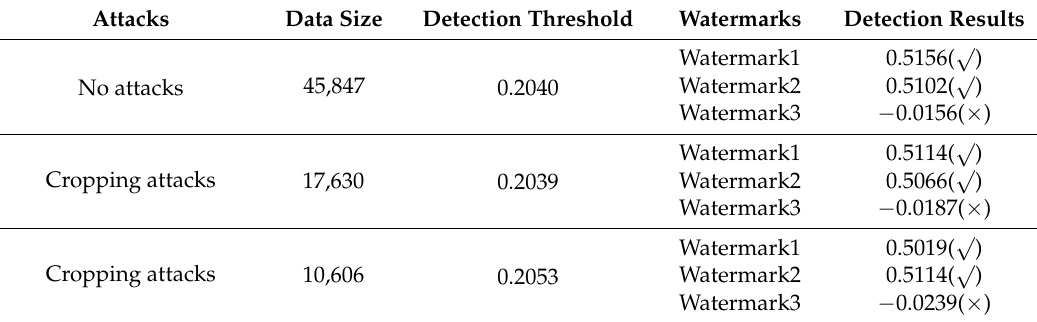
Table 4. The detection results after cropping of the experimental